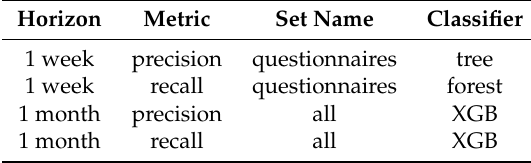
Table 4. Features importance configurations.